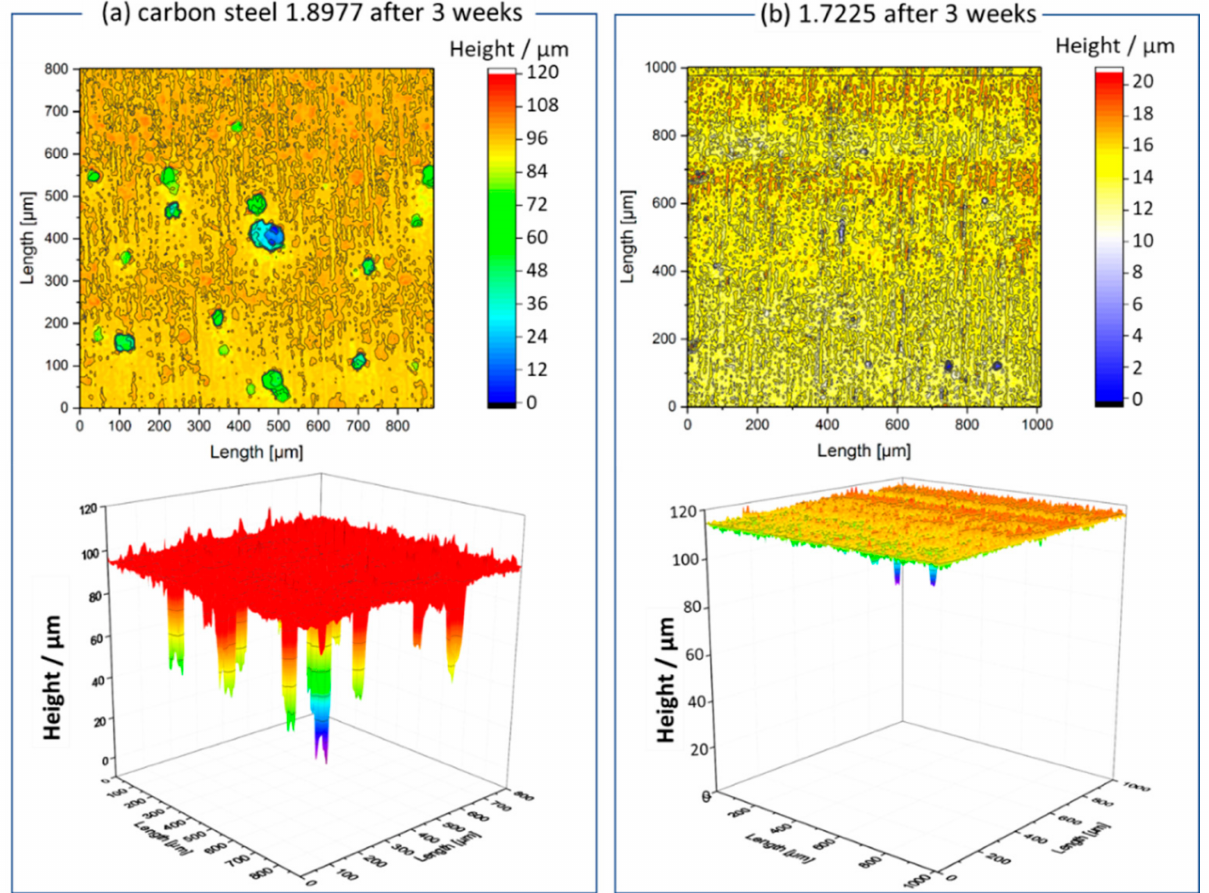
Figure 3. 3D surface scans of 3-week exposed ( a ) 1.8977 and ( b ) 1.7225 specimens in synthetic aquifer fluid at 333 K, ambient pressure, and continuous CO 2 flow via glass